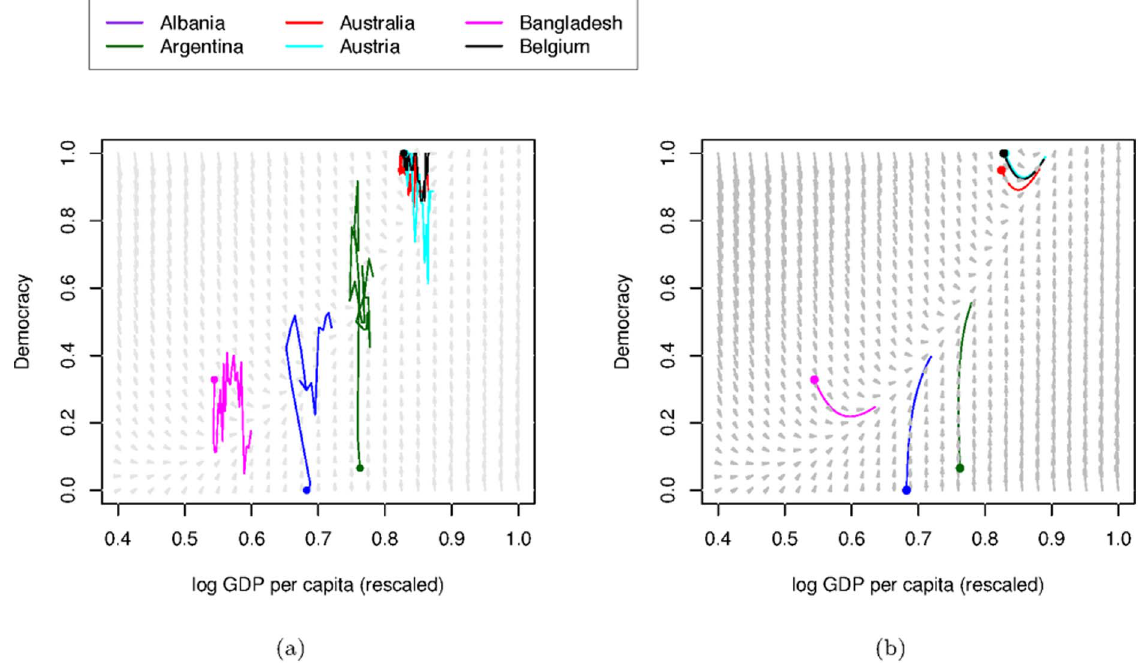
Figure 5. Phase portraits with trajectories. From (a) country by country data and (b) model predictions made by integrating equations 7 and 9, with coloured circles representing the initial conditions. The arrows in the phase portrait indicate the direction and magnitude of the changes dG and dD as a function of the two variables D and G themselves. Specifically the arrows are the vector ( dG , dD ) given by equations 7 and 9. These arrows are the same in both sub-figures.